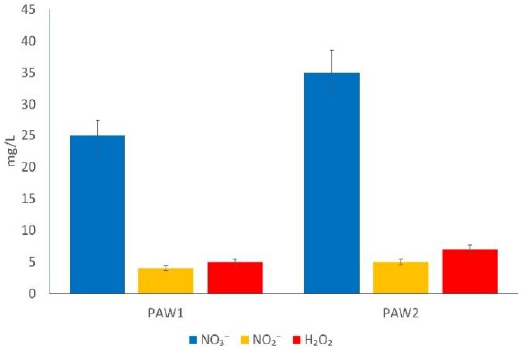
Figure 2. Concentrations of H 2 O 2 , NO 2 − , and NO 3 − in PAW1 and PAW2. Table 2. Energy efficiency (EEf) values used for the generation of H 2 O 2 , NO 2 − , and NO 3 − in PAW1 and PAW2. PAW1 and PAW2 enhanced the germination of wheat caryopses by 4.66% and 5.33%, EEf ( g/kWh ) PAW Frequency ( Hz ) H 2 O 2 NO 2- PAW1 Table 3. Effect of PAW treatment on the germination of Triticum aestivum L. cv. Glosa caryopses. Treatment